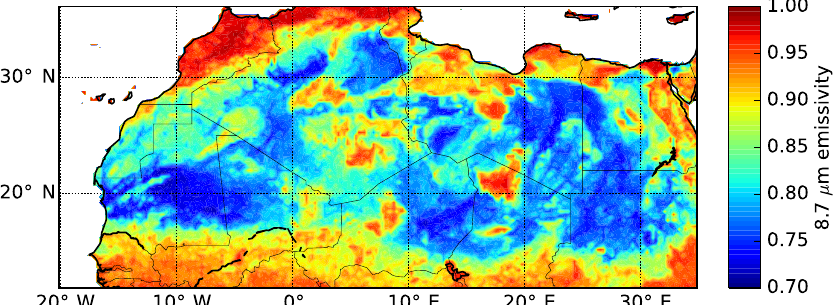
Figure 3. Map of climatological surface emissivity for the MSG-3 SEVIRI channel at 8.7µm used by the RTTOV program for June, derived by Borbas and Ruston (2010) using MODIS satellite